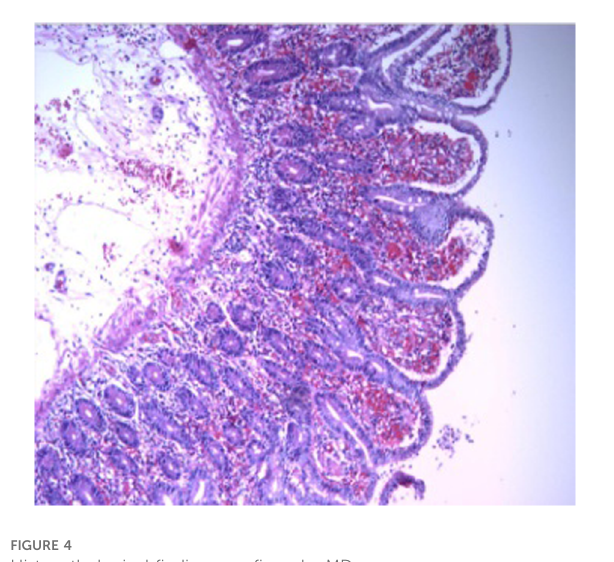
FIGURE 3 The MD was found during the